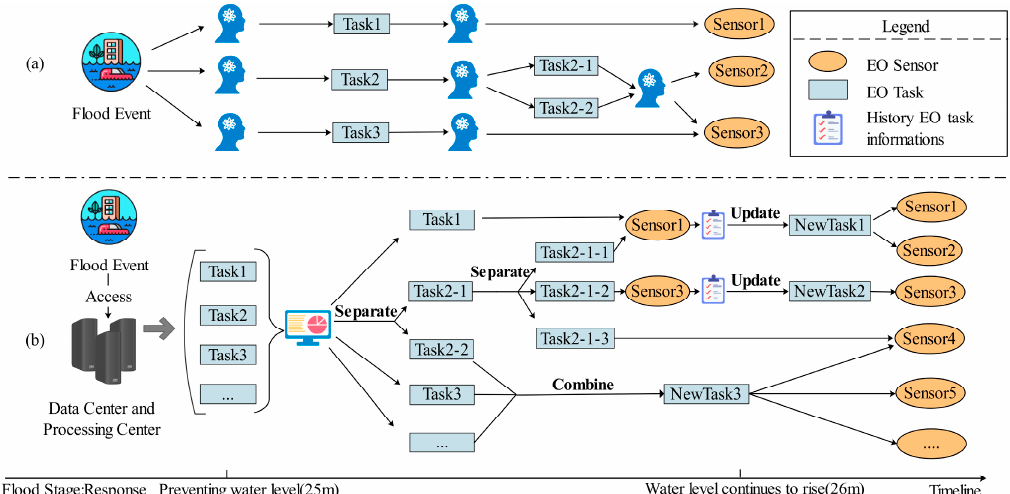
Figure 13. Comparison of models with and without a task process. ( a ) Diagram of an earth observa- tion task without a task process and ( b ) diagram of an earth observation task with a task process.